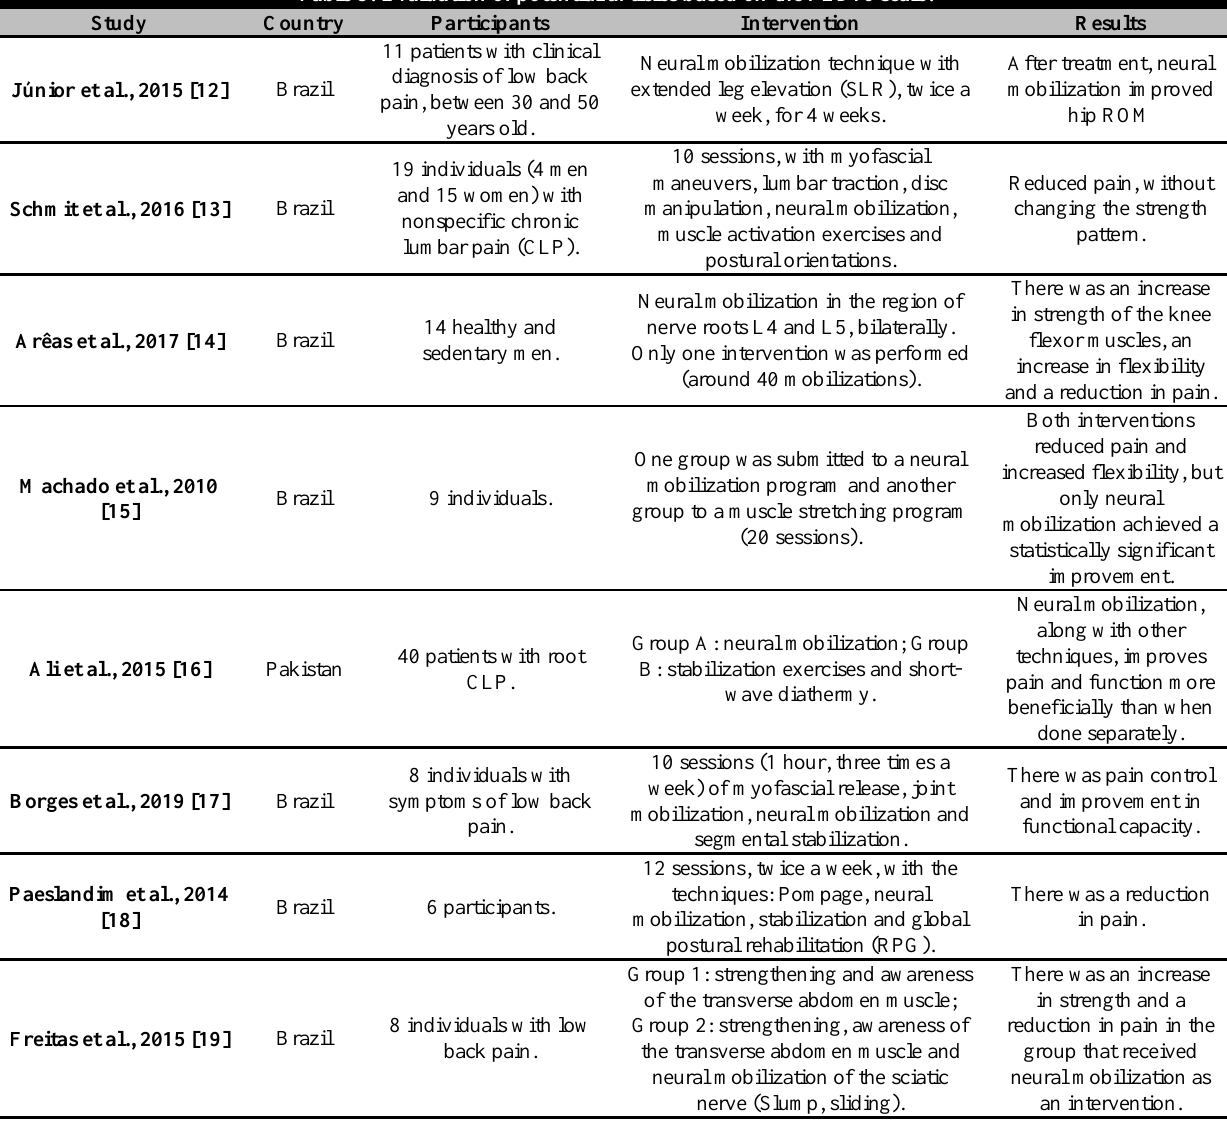
Table 3: Evaluation of potential articles based on the PEDro